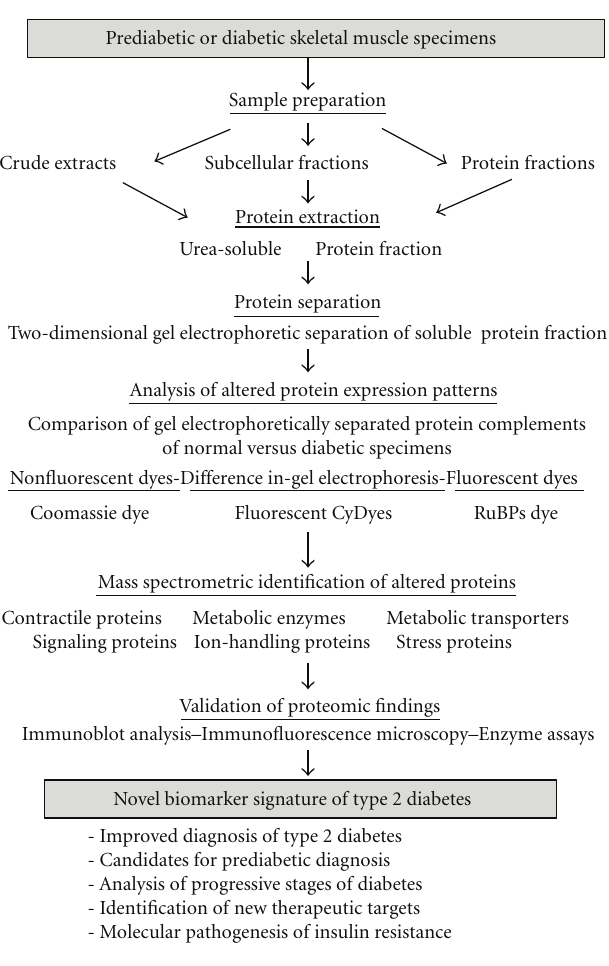
Figure 1: Proteomic profiling strategy to evaluate the e ff ect of type 2 diabetes on skeletal muscle tissues. Shown is a flowchart of the proteomic workflow to identify new protein factors involved in the molecular pathogenesis of insulin resistance, abnormal cellular signaling, and contractile weakness in diabetic skeletal muscle tissues. Listed are the various analytical steps of mass-spectrometry-based proteomic surveys of muscle samples, such as sample preparation, protein extraction, gel electrophoretic separation, densitometric scanning, mass spectrometric identification of novel biomarkers, and the independent validation of proteomic data by immunoblotting, enzyme assays, and immunofluorescence